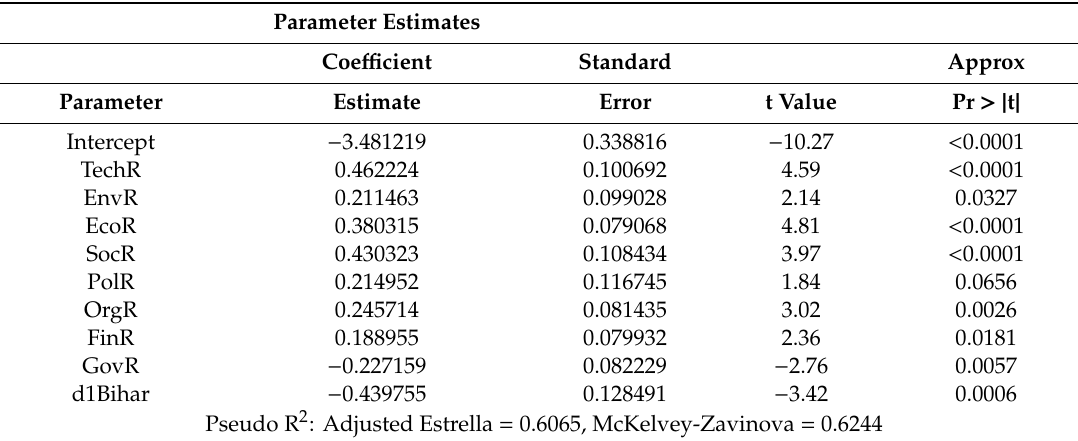
Table 10. Ordered probit regression results—rationalities and overall performance.